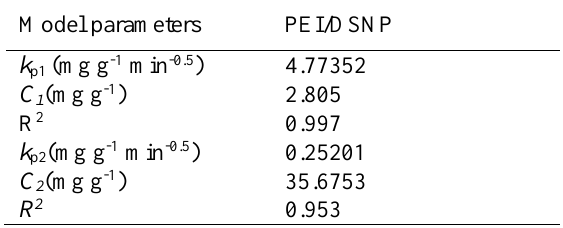
Table 3. Parameters of Weber-Morrismodel (Ci [Pb 2+ ] = 9 mg L -1 , pH =6; m/V = 135 mg L -1 , θ = 25 o